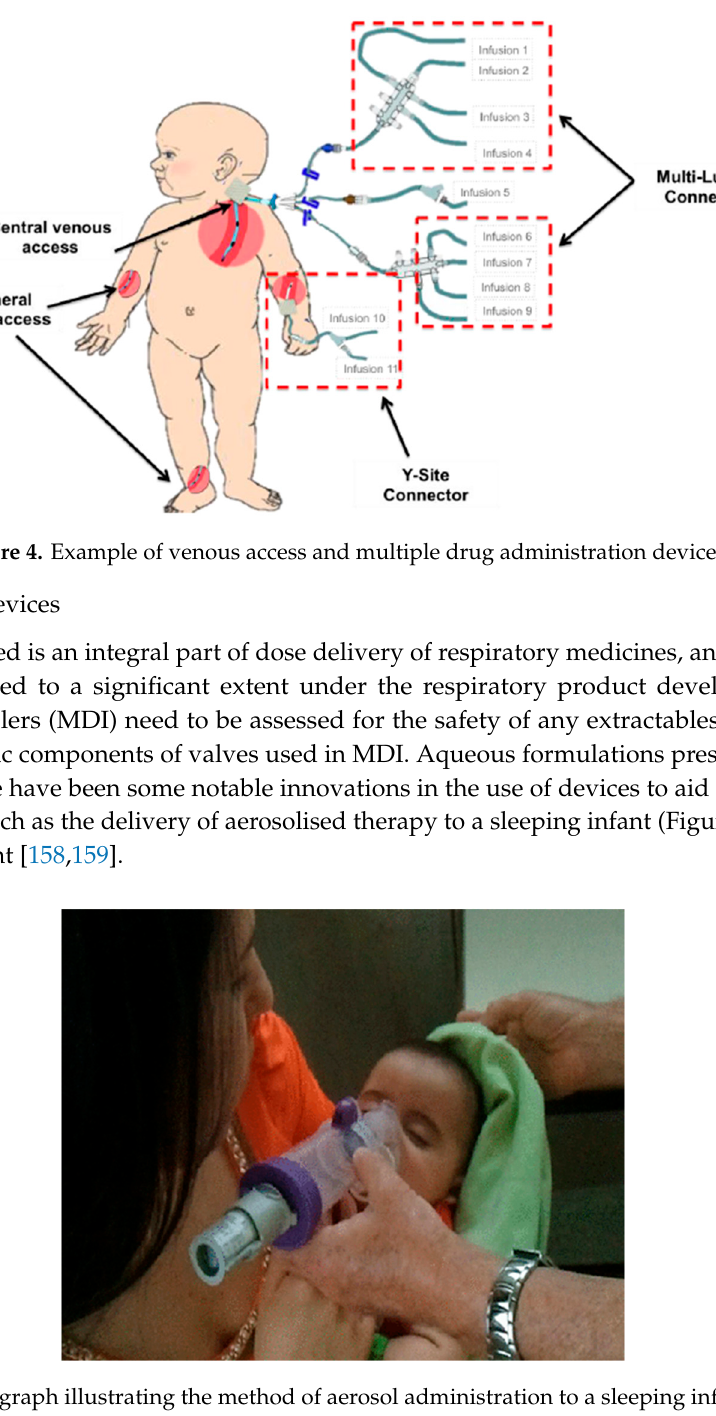
19 of 33 Figure 3. Different types of connectors (adapted from IV Sets and Access Devices Product Catalog—B. Braun Medical Inc., effective August 2017). In practice, multi-lumen and y-site connectors are often used to simultaneously deliver multiple